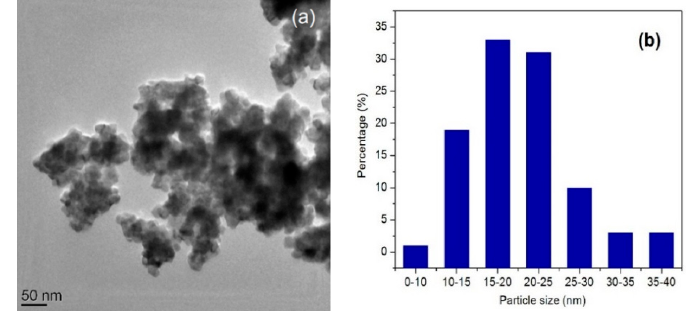
Figure 3. TEM image of calcined powder ( a ) and the corresponding particle size histogram ( b ).